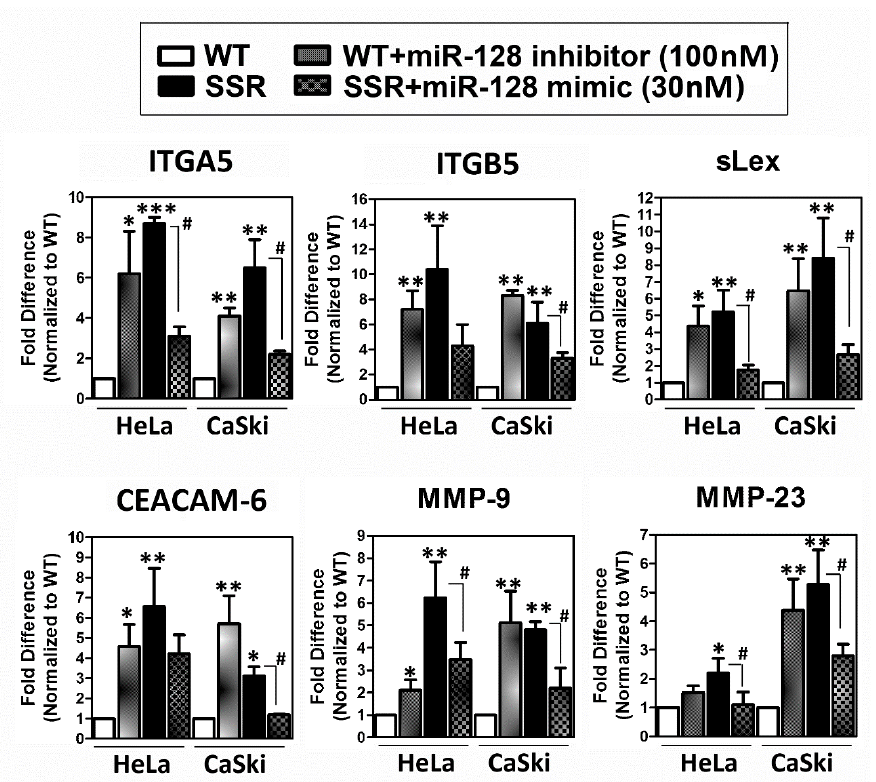
Figure 6. Effects of exogenous introduction of miR-128 on the expression of bioinformatics-predicted miR-128 targeted genes related to cell adhesion or cell invasion/metastasis. WT and SSR cells were transfected as described in Section 4.4 and then the cell extracts were collected for analysis of the transcription levels of various miR-128 targeted genes using quantitative PCR. For the transcription levels determined using messenger RNA (mRNA) extracted from WT cells treated with miR-128 inhibitor or SSR cells treated with miR-128 mimic , the values were first normalized to those of the 18S ribosomal RNA (abbreviated 18S rRNA ) internal control and then to the value obtained using mRNAs extracted from the WT scramble NC control. Data are given as mean ± SD; * P < 0.05, ** P < 0.01, *** P < 0.001 for the WT + miR-128 inhibitor group vs. WT + scramble NC group; # P < 0.05 for the SSR + miR-128 mimic group vs. SSR + scramble NC